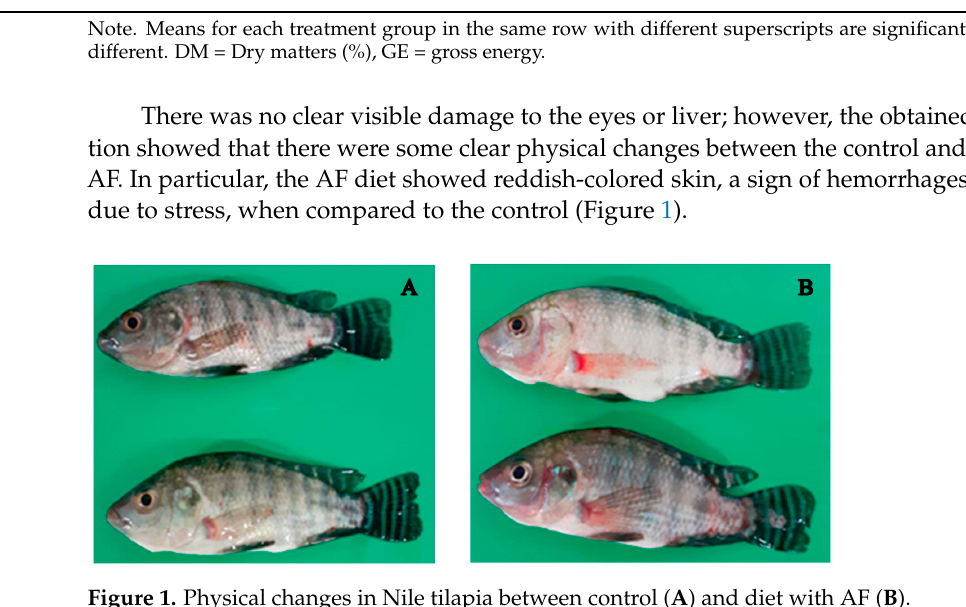
Figure 1. Physical changes in Nile tilapia between control ( A ) and diet with AF ( B ).